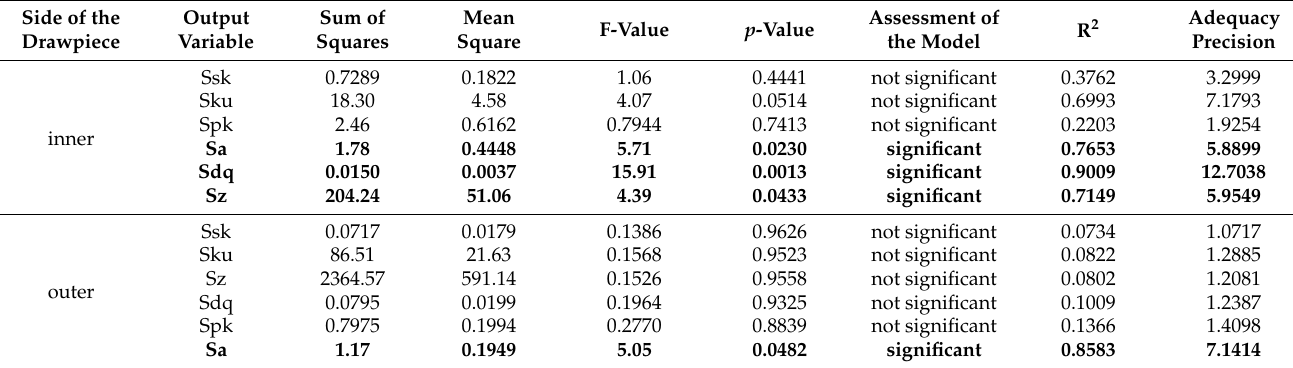
Table 10. Fit statistics of the models